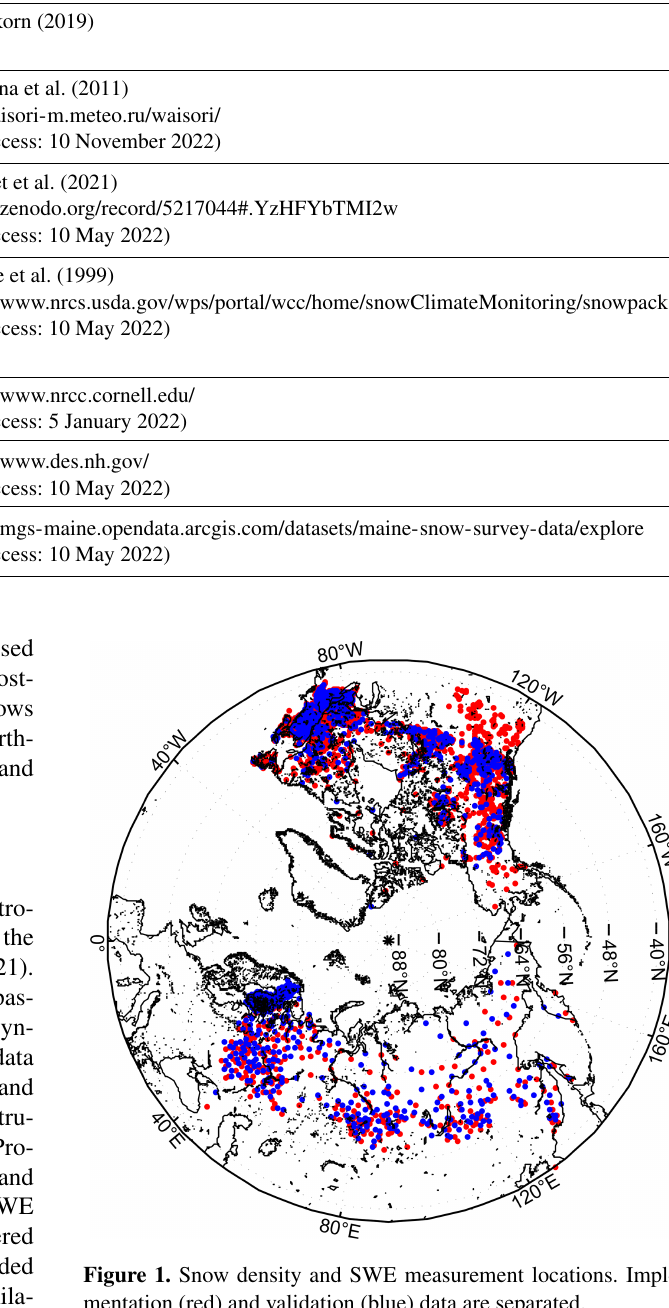
Table 1. An overview of SWE and snow density datasets. Region